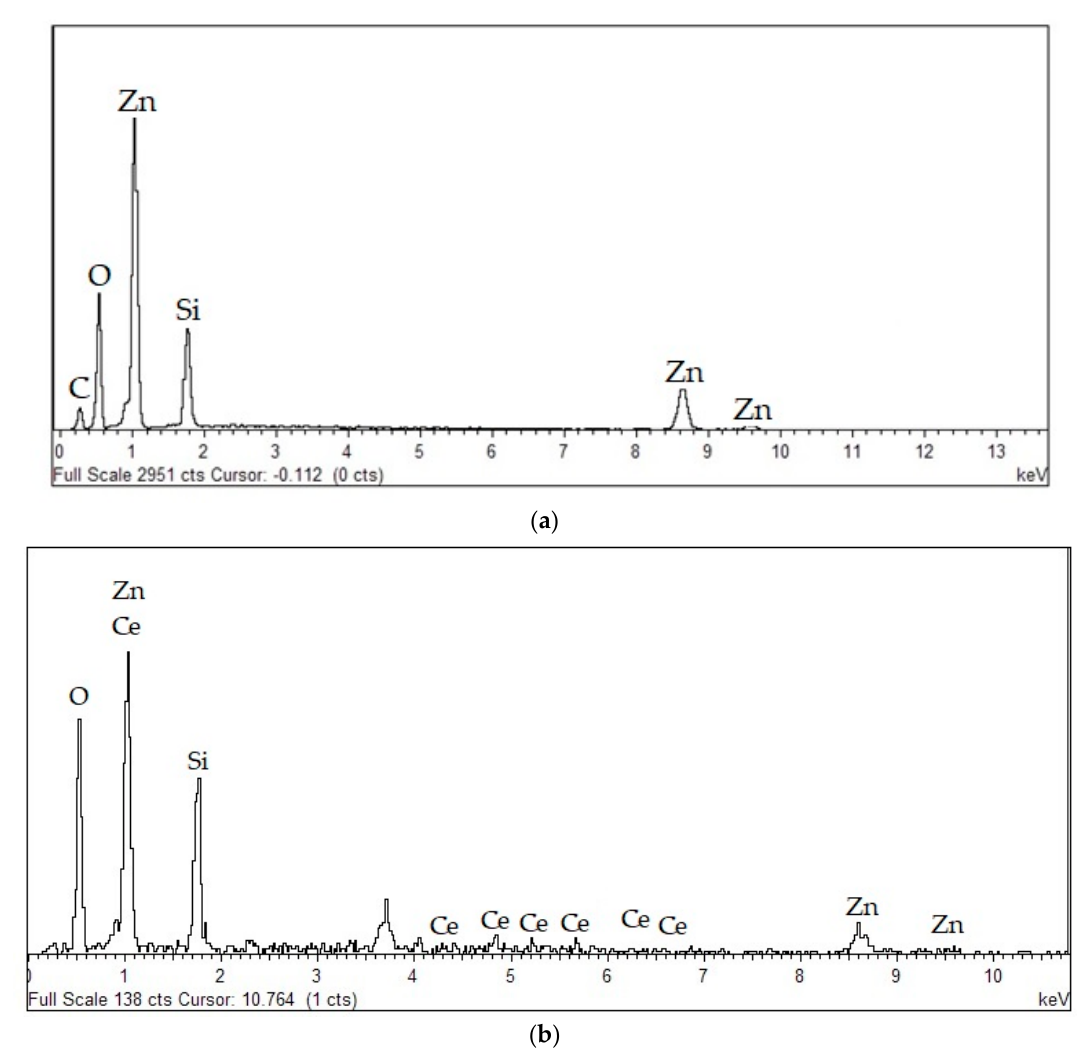
Figure 13. EDX spectra of ( a ) undoped willemite; ( b ) willemite: Ce 3+ 5 mol% calcined at 900 °C.